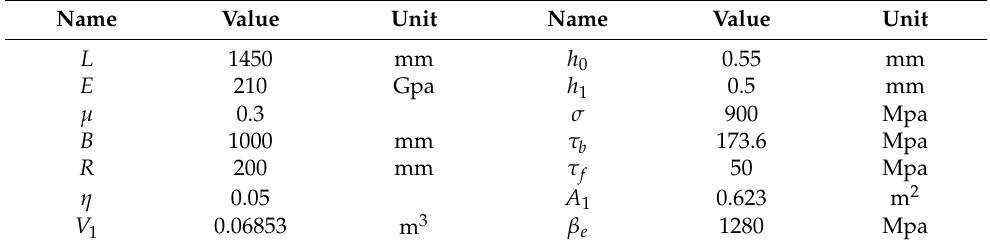
Table 2. Factory equipment and process